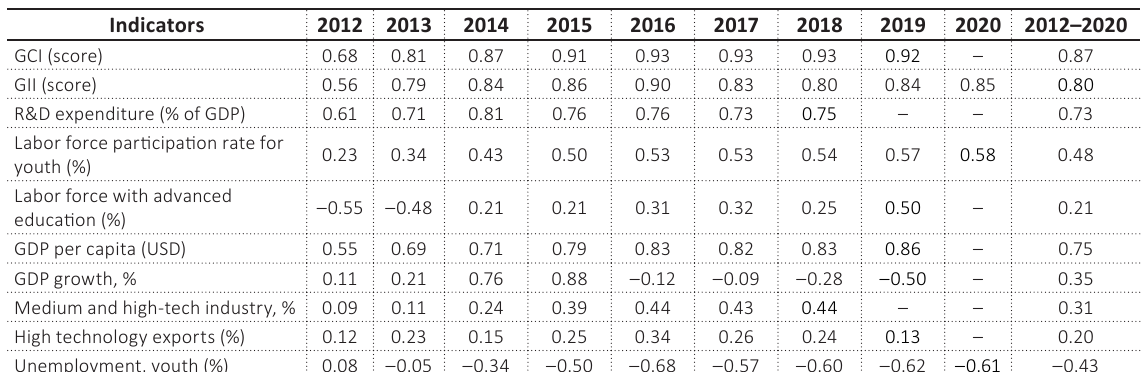
Table 4. Dynamics of correlation indices between the U21 higher education competitiveness index and selected economic development